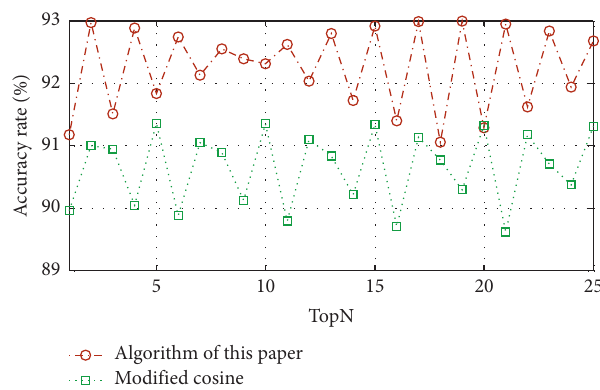
Figure 9: Comparison of accuracy of different similarity functions.